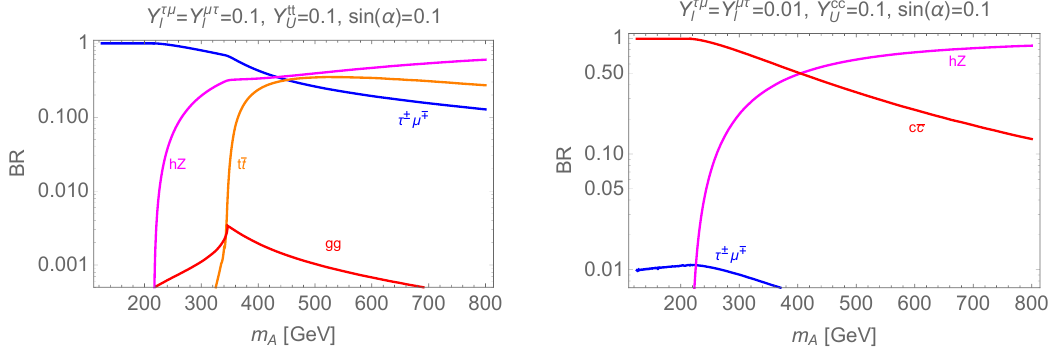
Figure 3. The branching ratios of the pseudoscalar A as a function of its mass. In both plots, Y (cid:28)(cid:22) = Y (cid:22)(cid:28) = 0 : 1 and sin (cid:11) = 0 : 1. The A ‘ ‘ channel in magenta and gg ( c (cid:22) c ) channel in red. On the left pane, Y tt Y cc = 0 : 1. Other Yukawa couplings are taken to be U